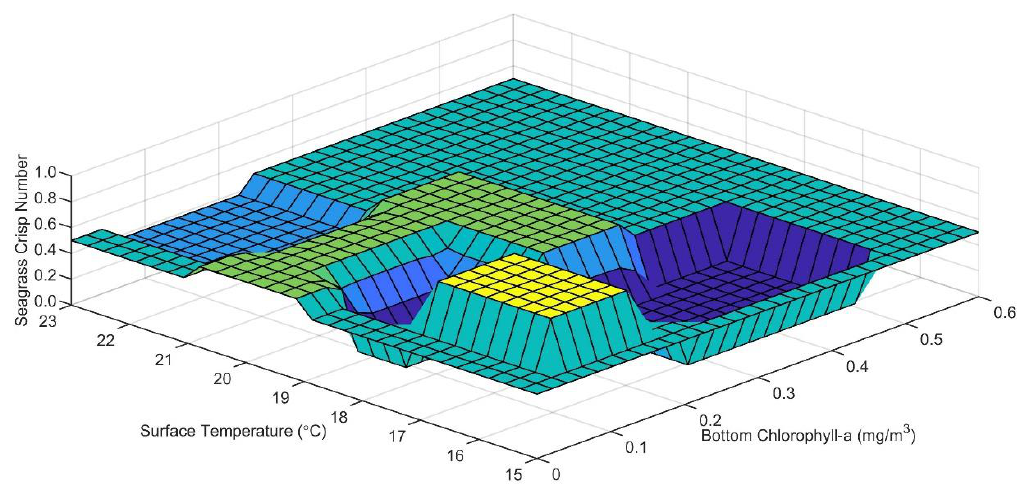
Figure 9. Three-dimensional surface produced by the optimum FIS, showing the environmental preferences of various seagrass families. (Yellow: Posidoniaceae; Dark Blue: Zosteraceae; Green: Cymodoceaceae; Light Blue: Hydrocharitaceae).